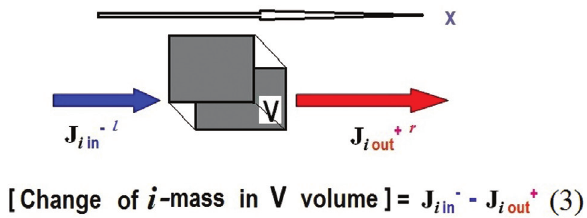
Figure 3 Illustration of mass balance partial differential Eq. (3), with its physical sense including J mass fluxes in V volume: input i -l , output ( right ) J + r . Eq. (3) is completed by inner “sink and ( left ) J i in i out source” J Fluxes presented in Figure k